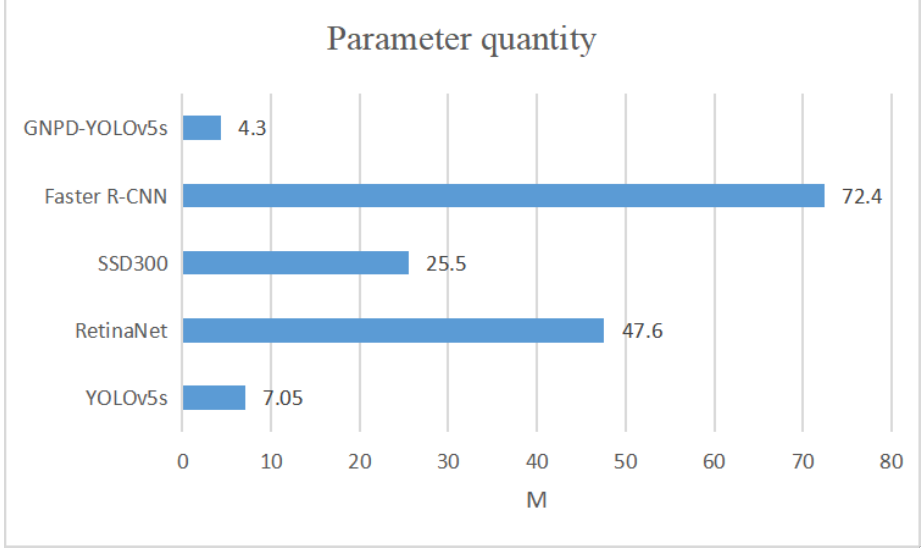
Figure 10. Comparison of parameters between GNPD - YOLOv5s chili detection model and other mainstream models.